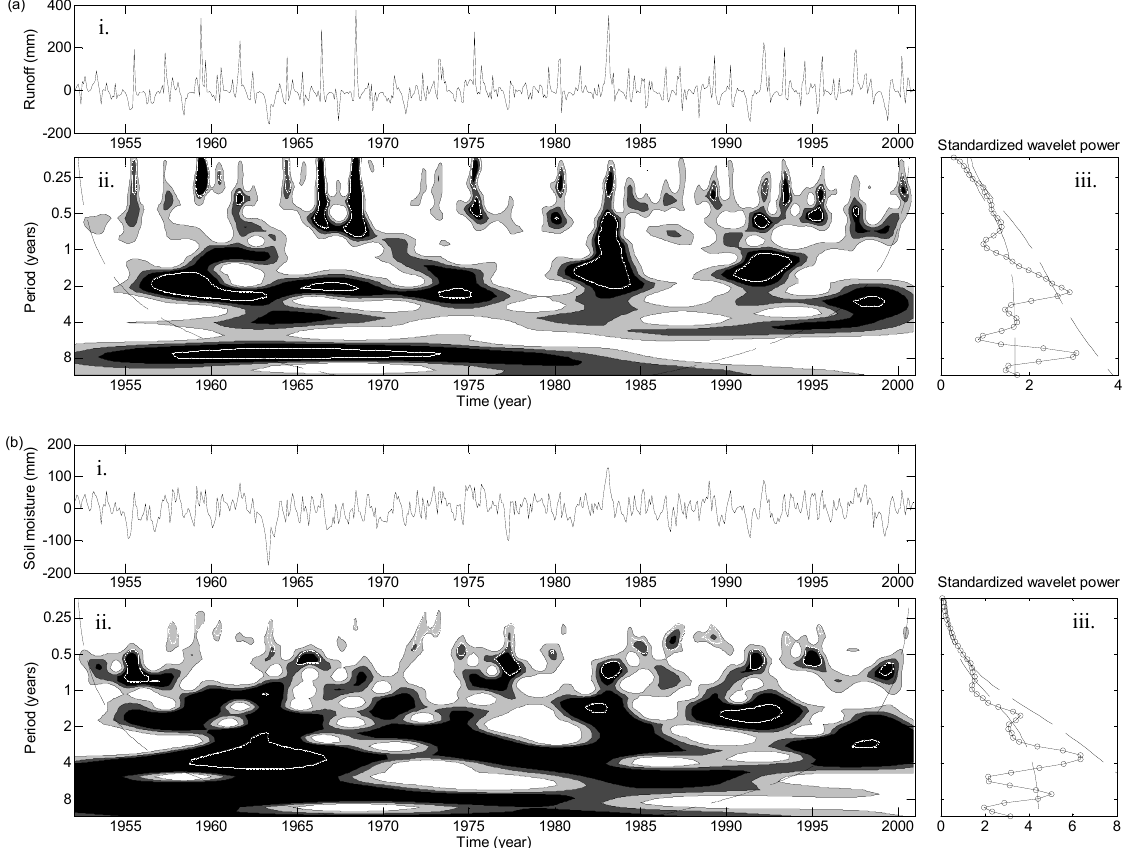
Fig. 2. (a) i. Monthly runoff anomaly time series at Boluo station in the East River and ii. Its local wavelet power spectrum using the Morlet wavelet, normalized by 1/ σ 2 ( σ 2 = 3,668.94 mm 2 ). The dashed curve depicts the cone of influence beyond which the edge effects become important. The shaded contours are at normalized variances of 1, 2 and 4. The white contour closes regions of greater than 95% confidence for a red-noise process with a lag-1 coefficient α of 0.26. iii. Global wavelet power (solid line with circles), mean red-noise spectrum (left dashed line), and 95% confidence spectrum (right dashed line). (b) same as (a) but for soil moisture, in which ( σ 2 = 1,342.57 mm 2 , α = 0.64).